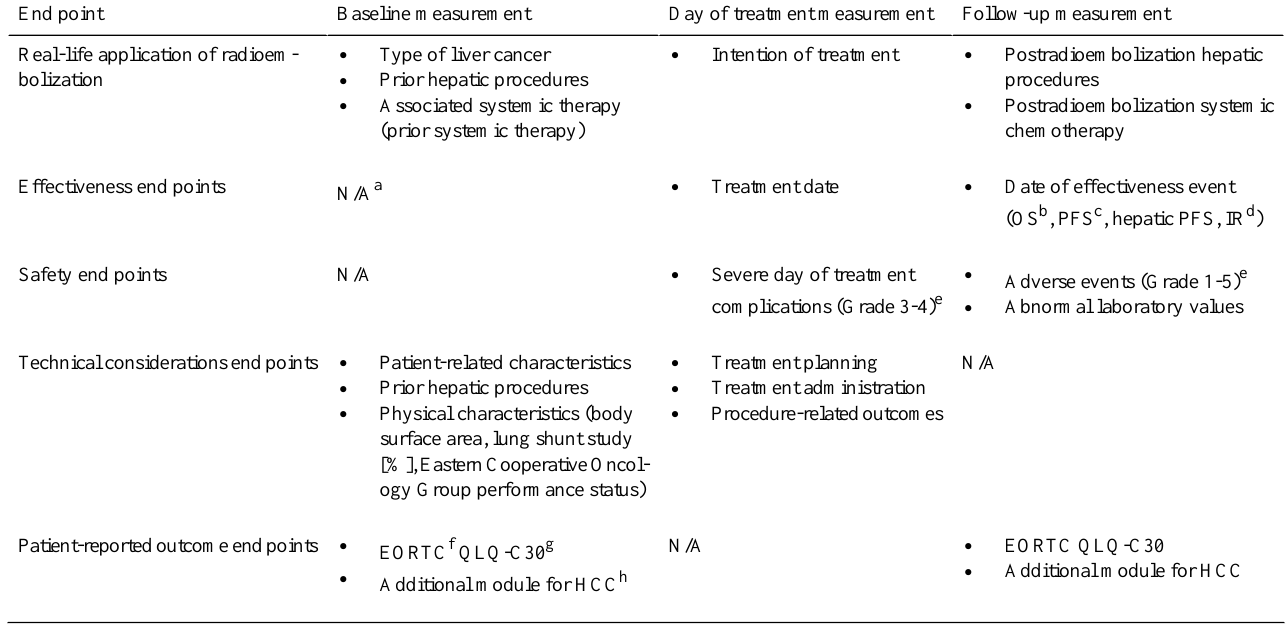
Table 1. Time of measurement for each end point and associated measurements.